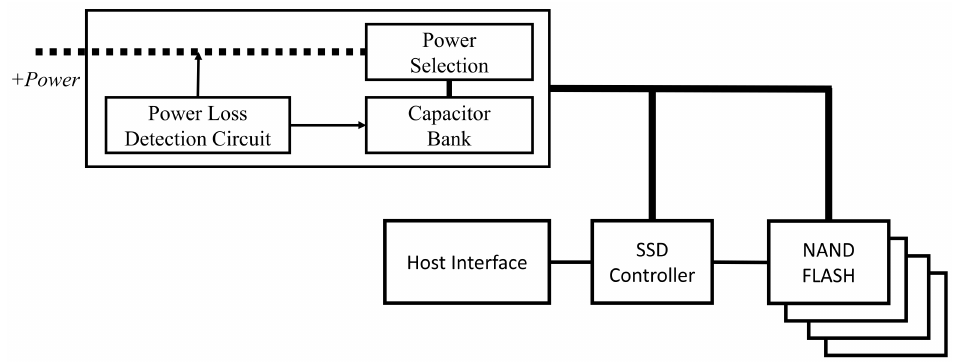
Figure 2. Block diagram of power-loss protection